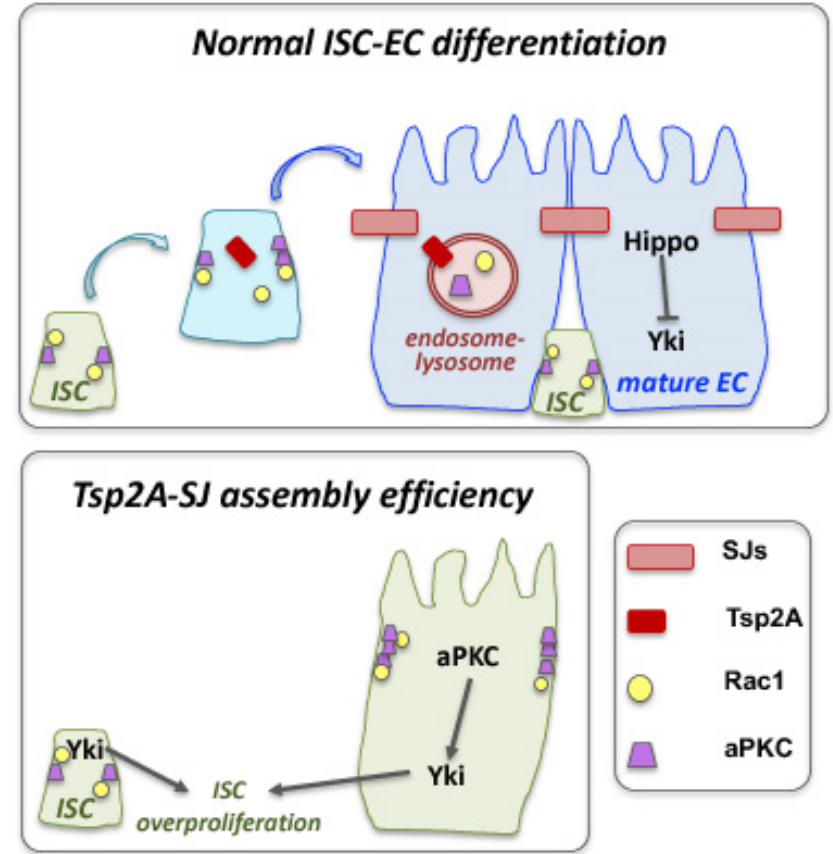
Figure 5. Crosstalk of septate junctions and cell compartmentation with signaling and fate determination in the Drosophila intestine . The septate junction (SJ) and transmembrane protein tetraspanin 2A (Tsp2A) plays a critical role in the differentiation of intestinal stem cells (ISCs) to adapt the absorptive enterocyte (EC) fate, by promoting SJ assembly and modulating the function of the atypical protein kinase C (aPKC). The presence of a functional Tsp2A in differentiating ISCs promotes the degradation of aPKC, which antagonizes the Hippo pathway. This permits Hippo activation that inactivates Yki. Loss of Tsp2A, prevents SJ formation, affects the localization of adherens junction components and aPKC leads to Yki hyperactivation and overproliferation of ISC cells (diagram adapted with modifications from Ref. [174] ).